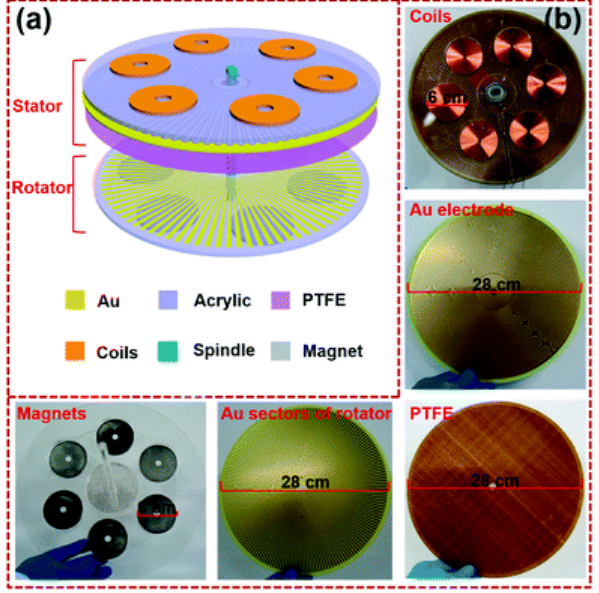
Figure 27. Diagram of the hybridized nanogenerator: coils are on the stator, magnets on the rotator ( a ); photographs of the hybridized nanogenerator ( b ) [63].